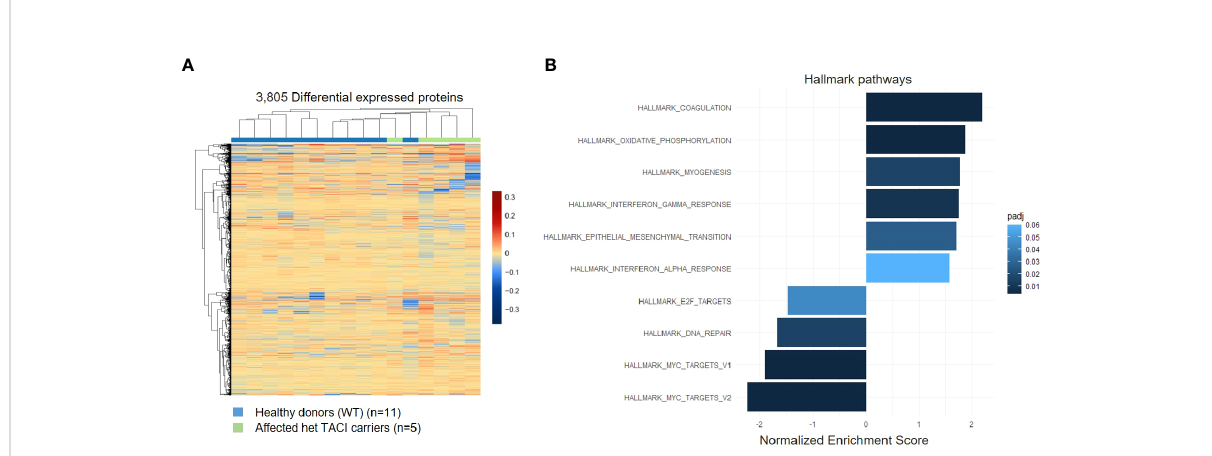
FIGURE 5 Proteome analysis of stimulated naïve B cells from TACI mutation carriers and healthy donors. (A) Heatmap of differentially expressed proteins for stimulated naïve B cells from TACI mutation carriers and WT (log2 fold change >0.5) Red: upregulated proteins; blue: downregulated proteins. (B) Statistically over-represented Hallmark pathways associated with increased (right bars) or decreased (left bars) differentially expressed proteins depicted by the